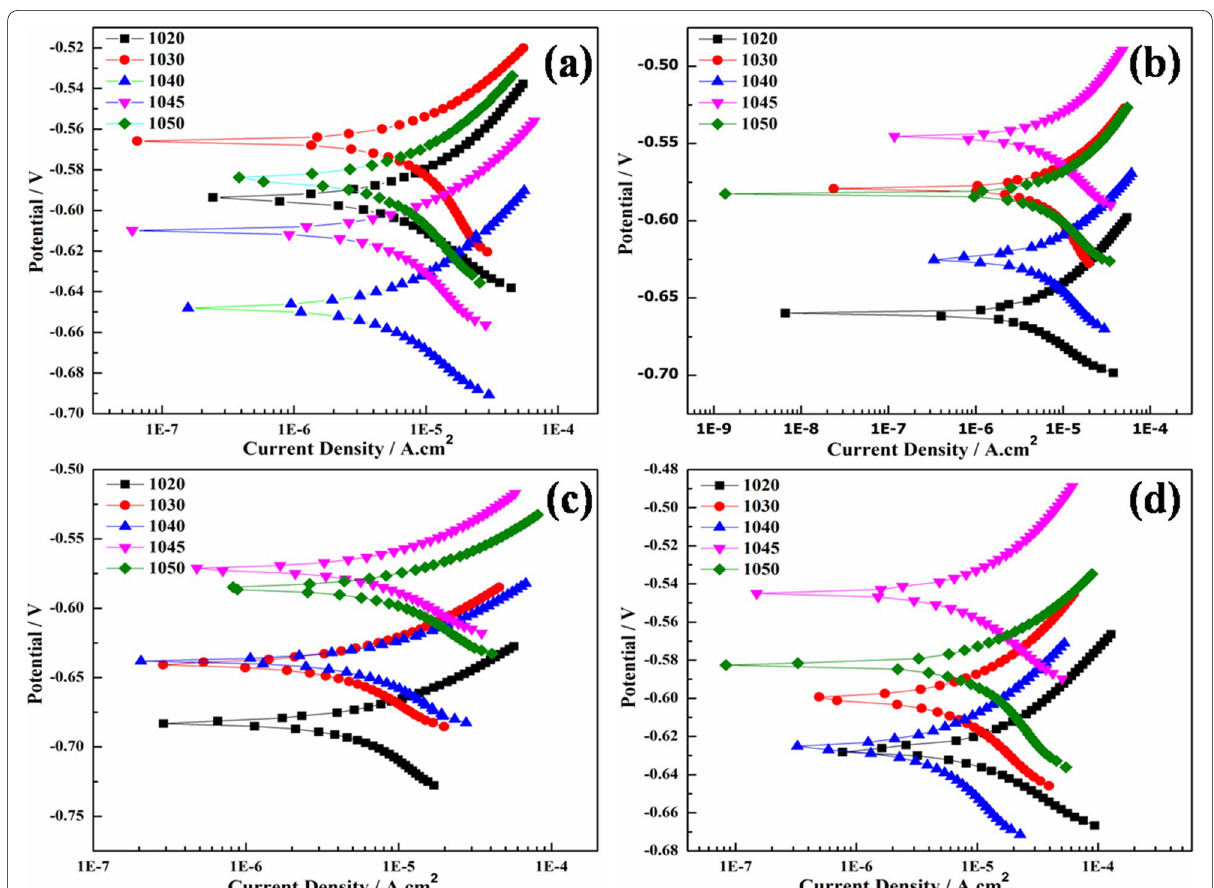
Fig. 7 Tafel scan plots of plain carbon steels a coarse ferrite-pearlite, b fine ferrite-pearlite, c lath martensite, and d bainite